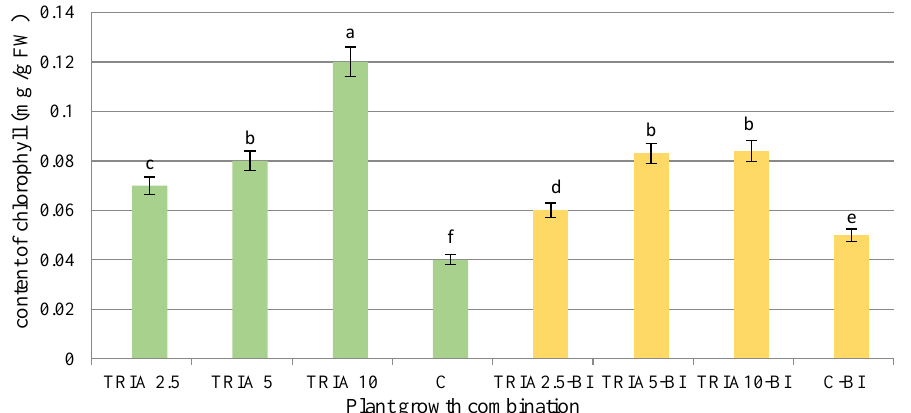
Figure 4. Effect of triacontanol on chlorophyll content in shoots of D. forrestii cultured for five weeks on MS medium containing TRIA (µg/L) or TRIA (µg/L) and 0.5 mg/L BAP and 0.2 mg/L IAA (TRIA-BI), C-medium without growth regulators, C-BI- medium with 0.5 mg/BAP and 0.2 mg/L IAA. The values represented means ± SE of three independent experimental replicates. The means marked with various letters for the same parameter were different at p < 0.05 according to a Tukey’s test.